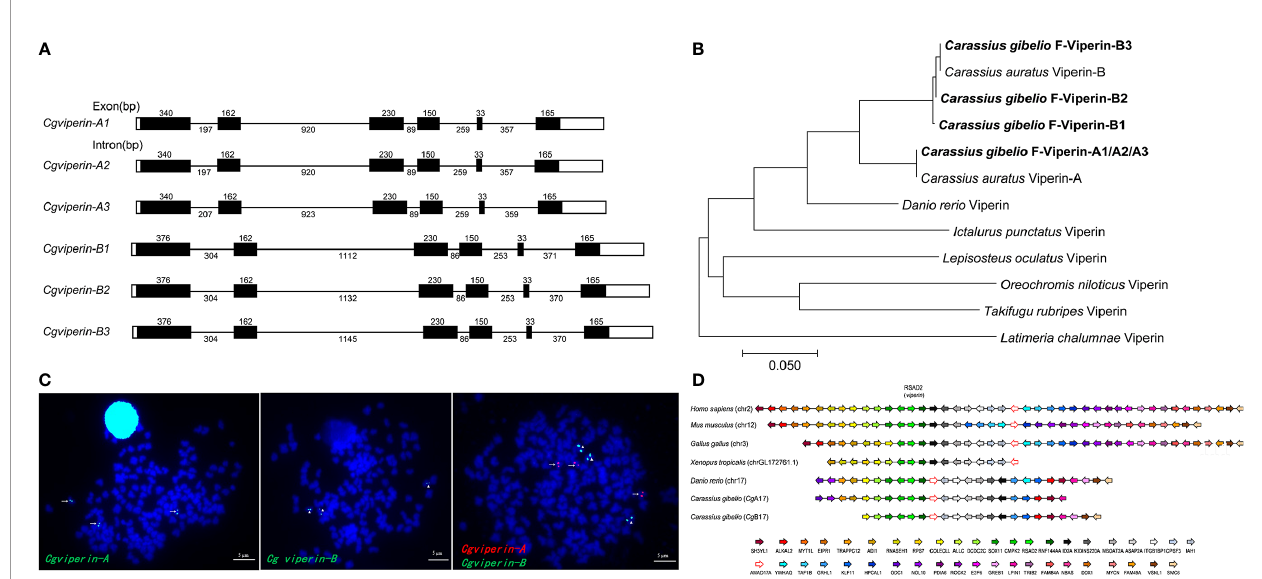
FIGURE 1 | Molecular characterization of Cgviperin -A and Cgviperin -B in gibel carp. (A) Genomic structure of six Cgviperin genes. Exons and introns are depicted by rectangle boxes and thick lines, respectively, and ORFs are highlighted by black boxes. Sizes (bp) are indicated upon or below themselves. (B) Phylogenetic tree of vertebrate Viperin. (C) Localization of Cgviperin -A and Cgviperin -B on gibel carp metaphase chromosomes. Cgviperin -A-BAC-DNA probe was labeled with DIG (green signals) or Biotin (red signals) (indicated by arrows), and Cgviperin -B-BAC-DNA probe was labeled with DIG (indicated by arrowheads). All metaphase chromosomes (blue) were counterstained with DAPI. (D) Gene synteny of vertebrate viperin . Conserved gene blocks are represented in matching colors. Transcription orientations are indicated by